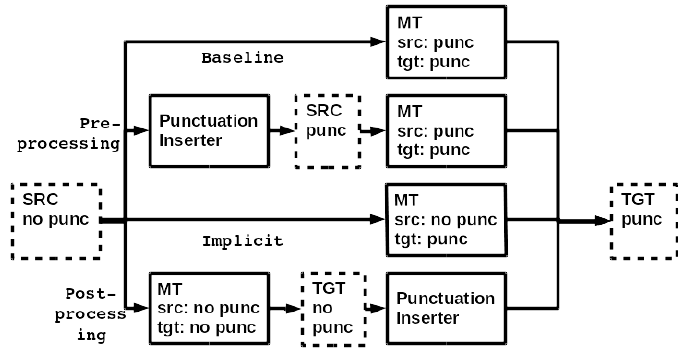
Figure 11. The different punctuation prediction strategies in a translation